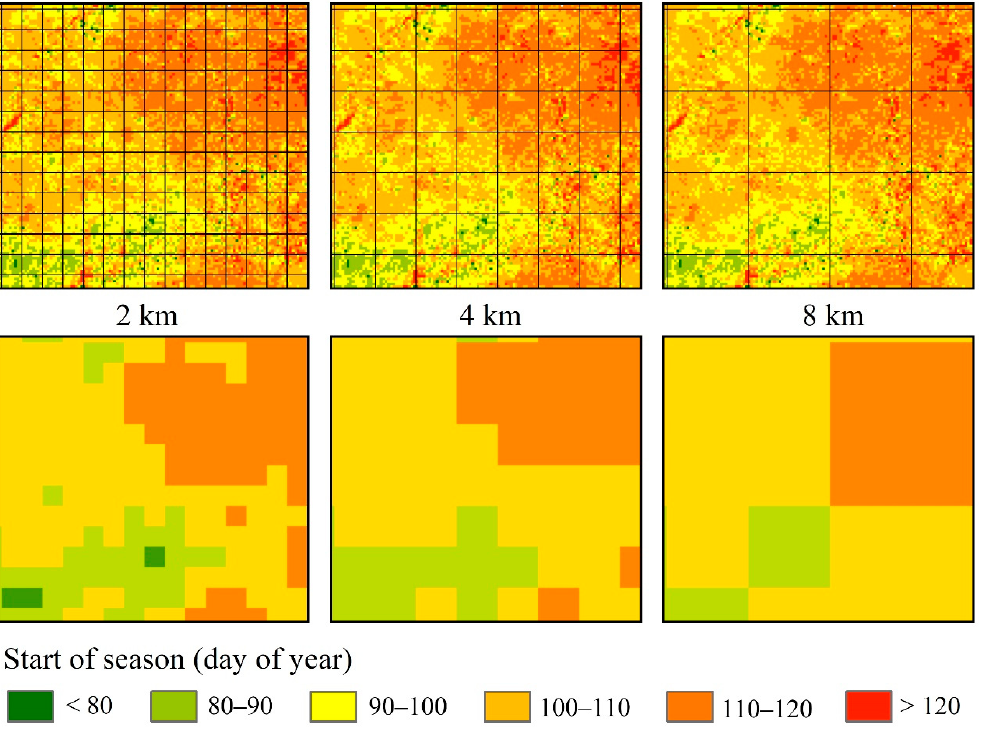
Figure 5. Example illustration of the 250-m SOS up-scaled to 2 km, 4 km, and 8 km using the spa- tial averaging method. averaging